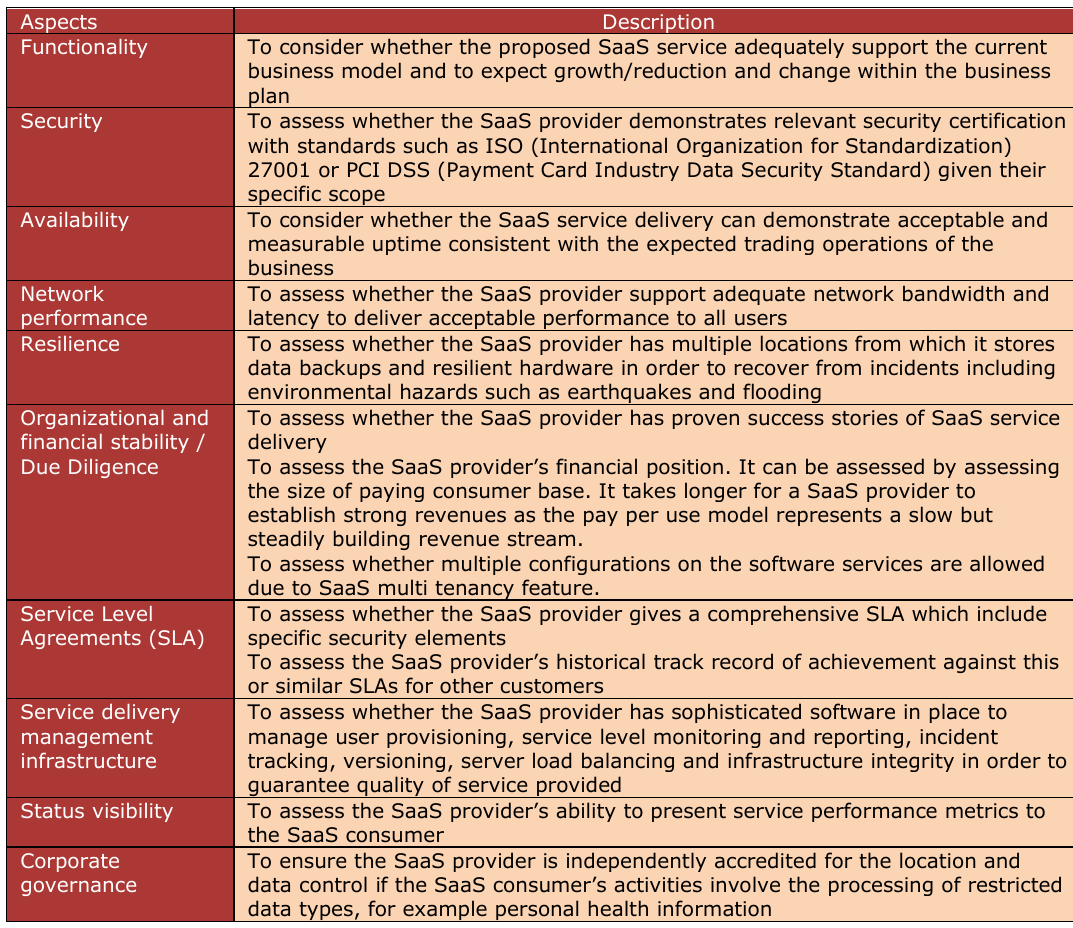
Table 1. SaaS aspects to consider before adoption (adapted from Deloitte, 2010; Edwards, 2008; Herbert, 2010; Wainewright,